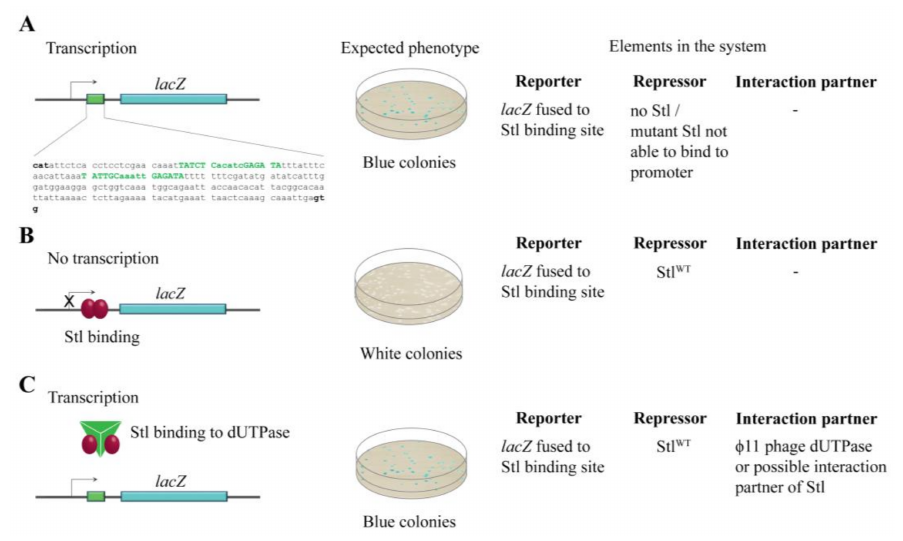
Figure 1. The design of the switch system. ( A ) In the absence of Stl-binding to its recognition sequence, lacZ can be expressed in the cell, leading to blue colonies in the experimental setup. The exact sequence from the SaPI bov1 genome (13733–13933) cloned into the lacZ promoter is shown. Specific Stl binding sites are labeled with green, conserved sites are shown with capital letters; ( B ) Stl binding to the promoter inhibits lacZ expression, leading to white colonies in the experimental setup; ( C ) The phage dUTPase protein sequestrates Stl WT from the promoter DNA segment, leading to blue